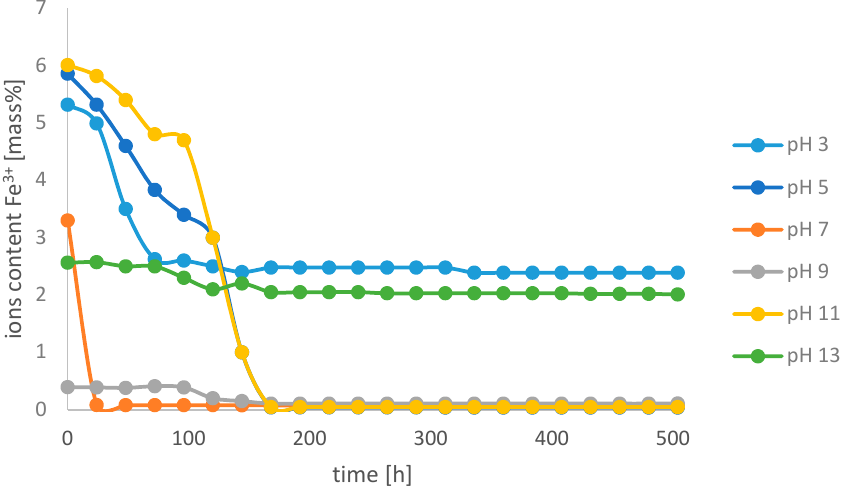
Figure 6. Change in the content of Fe 3+ ions over time at different pH values in the pH electrolyte environment in the iron(III) ethylenediamine- N,N ′ -bis(hydroxyphenylacetic) acid solution. The lowest content of iron(III) ions in the aquatic environment was observed at pH 7. On the third day of the experiment, the content of free ions was 0.07%. In such an environment, the unbound iron ions only react with the chelator and do not undergo other reactions. The highest content was observed at pH 3 and 13. The greatest decrease in the content of ions was observed at pH 11, which is caused by the precipitation of iron(III) hydroxide. Within 168 h of the experiment, the content of free iron ions stabilized and did not change significantly until the end of the experiment. The results obtained indicate that the composition of the solution undergoes slight changes over time. Figure 7 shows the changes in the content of Fe 3+ ions in the base electrolyte environment in the Fe-EDDHSA chelate sample at different pH values. Figure 7. Change in the content of Fe 3+ ions over time at different pH values in the pH electrolyte environment in the iron(III) ethylenediamine- N,N ′ -di[(2-hydroxy-5-sulfophenyl)acetic acid] solution. The highest concentration of free ions was observed at pH 3, and successively at pH 5 and 13. Their content in the case of t = 500 h was 3.35%, 0.71%, and 0.66%, respectively.